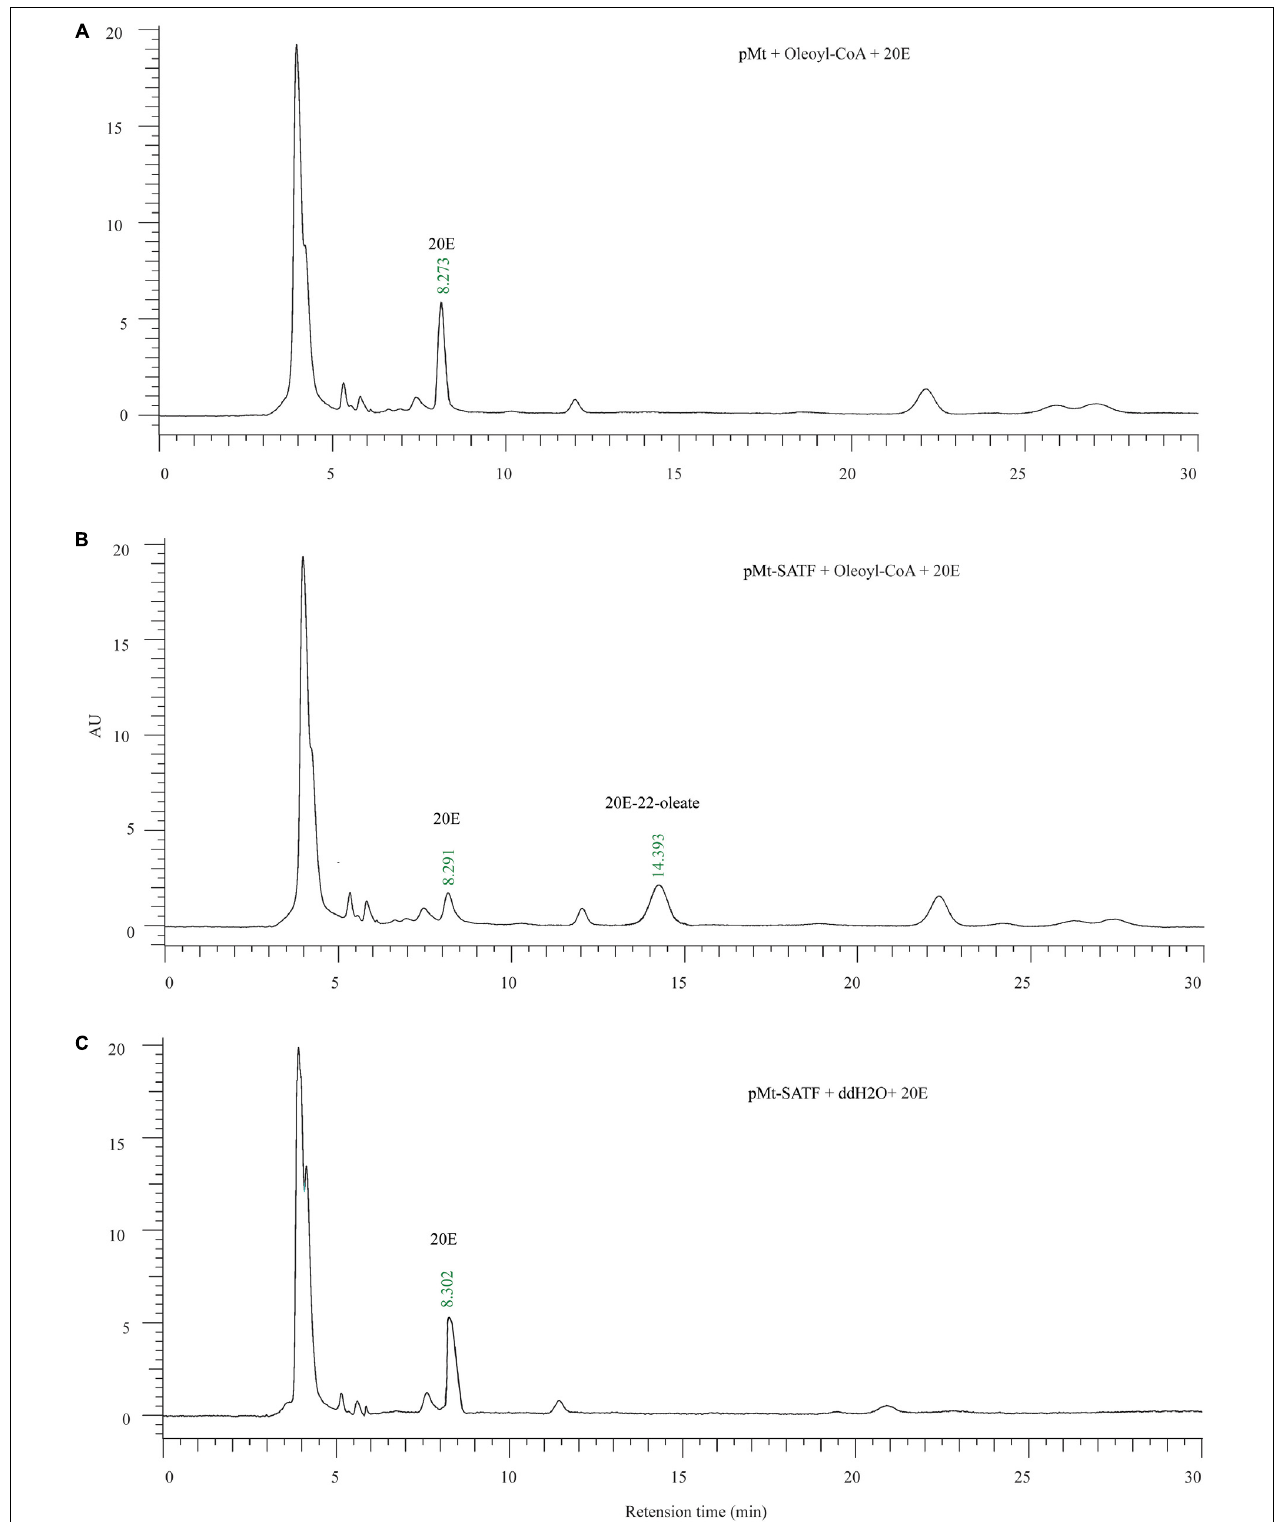
FIGURE 5 | Enzymic activity of recombinant Sterol O-acyltransferase, SATF proteins. (A) The enzyme assay of the supernatant of the control vector (pMt) infected cell with the 20E and Oleoyl-CoA. (B) The enzyme assay of the supernatant of the pMt-SATF infected cell with the 20E and Oleoyl-CoA. (C) The enzyme assay of the supernatant of the pMt-SATF infected cell with the 20E and water.